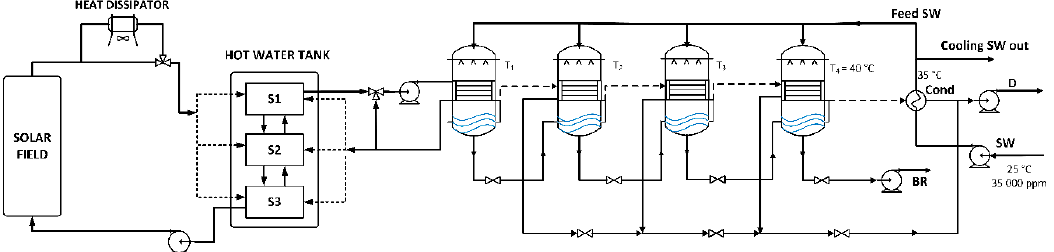
Figure 1. Sketch of the investigated system (solar field, hot water tank, and parallel/cross multi-effect desalination (MED)). Details of the connections of the tank according to flow temperatures.